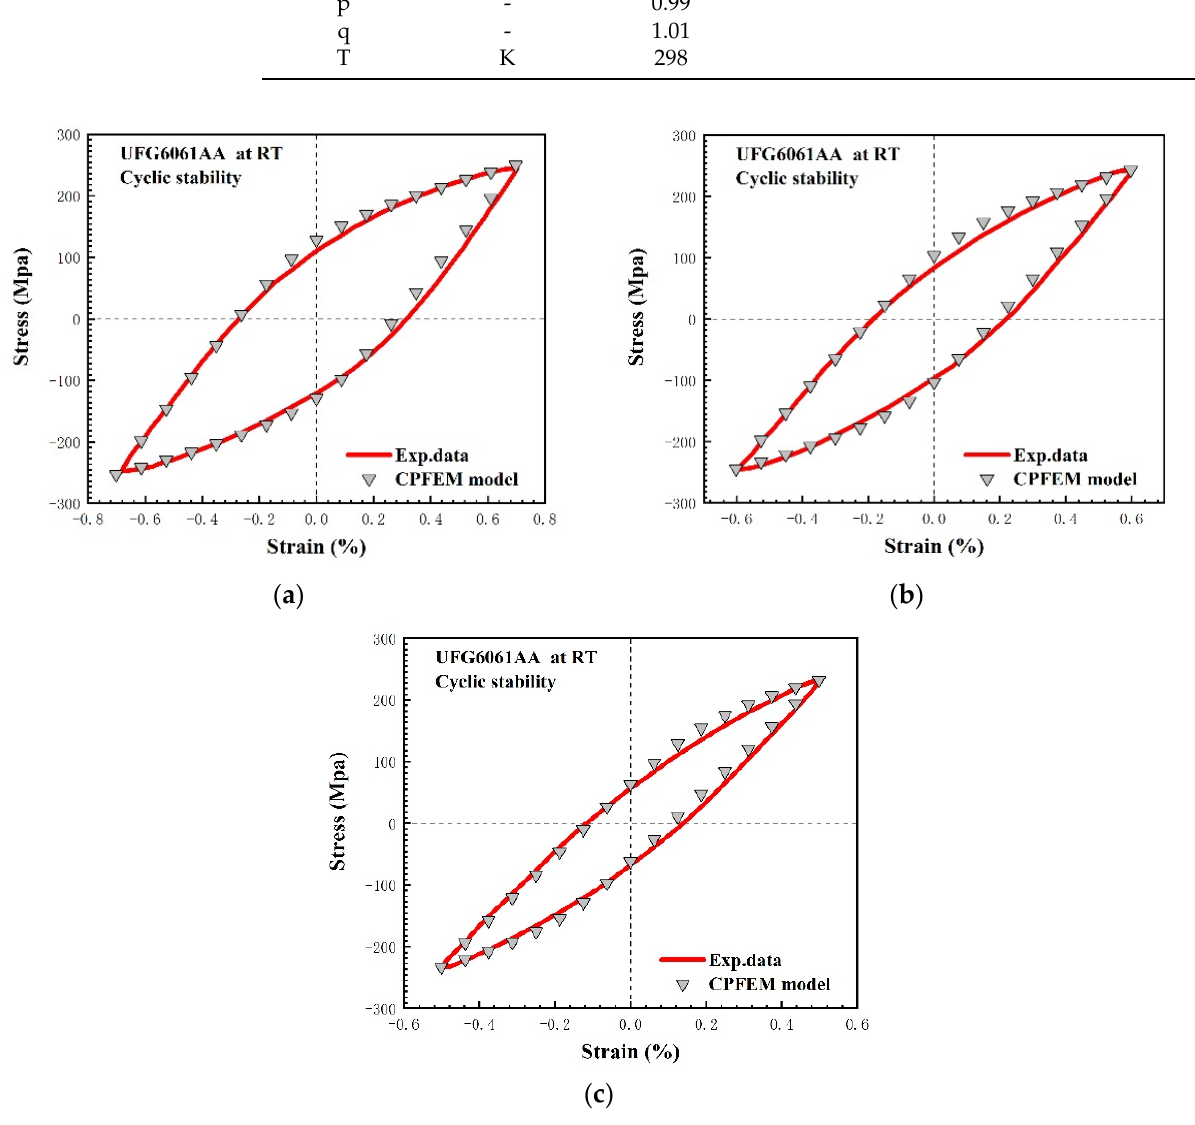
Figure 7. Comparison between the experimental and computational cyclic stress–strain curves in terms of hysteresis loops: ( a ) 0.005; ( b ) 0.006; ( c ) 0.007. Table 2. Material parameters for CPFEM simulation.